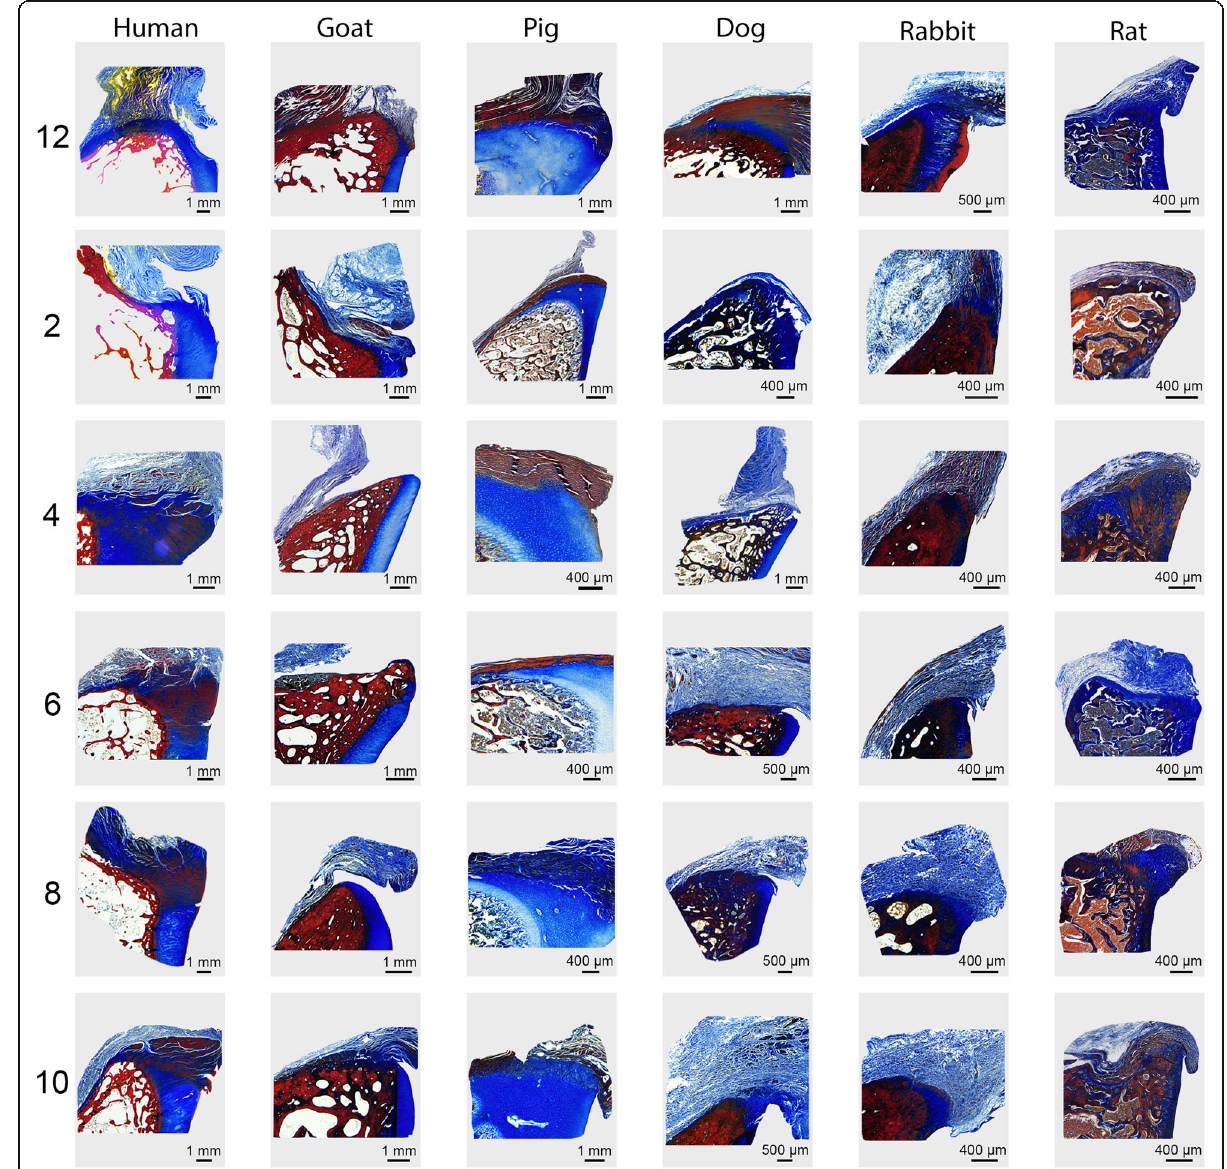
Fig. 5 Higher magnification Mallory trichrome-stained sections of the glenocapsular junction at each clockface position across